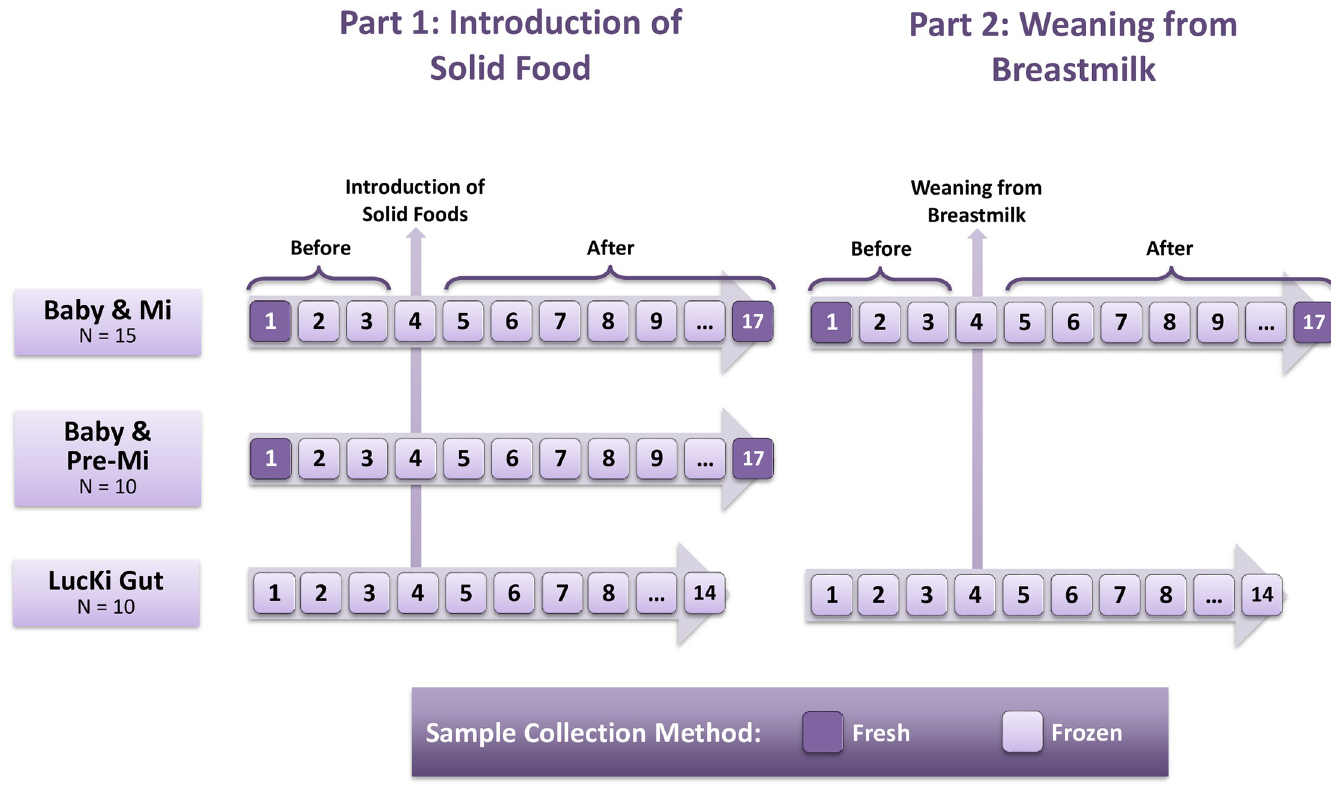
Fig 1. Diagram of sample collection for the Intensively Sampled